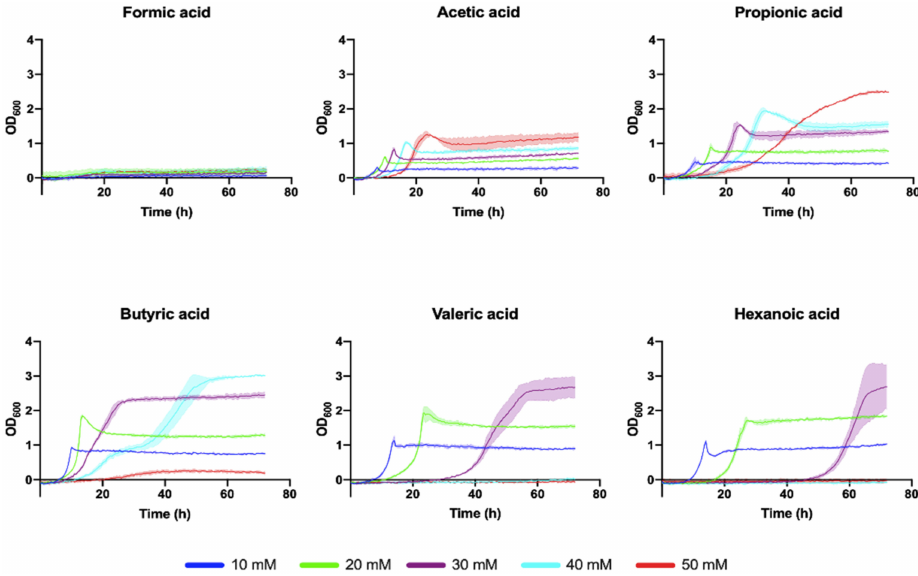
Figure 1. Growth of C. necator H16 with varying concentration of volatile fatty acids (VFAs). Legend: 10 mM—blue, 20 mM—green, 30 mM—purple, 40 mM—cyan, 50